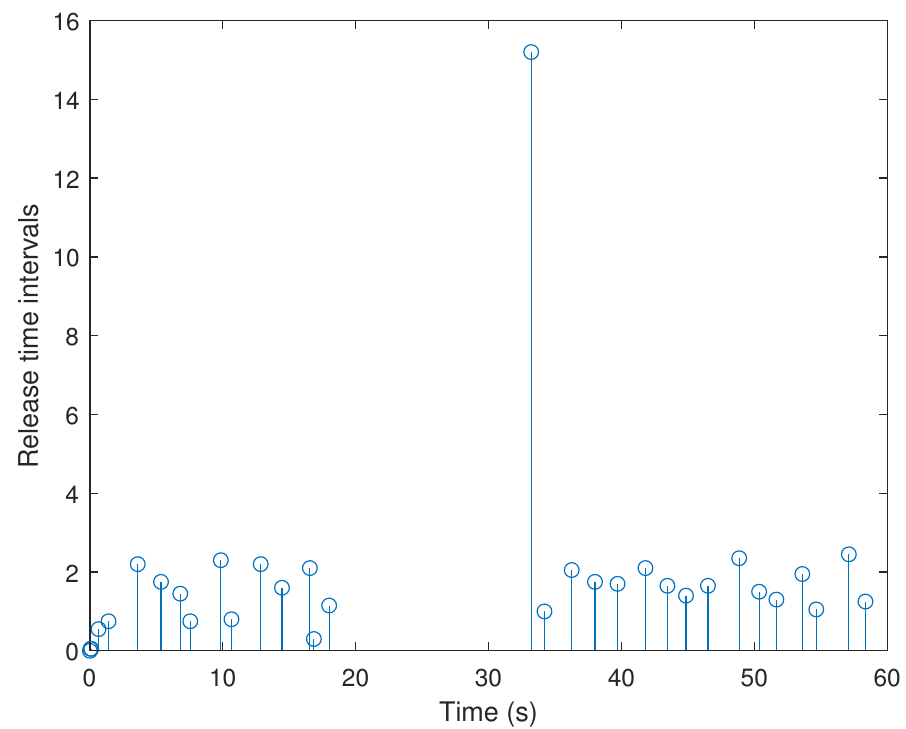
Figure 10. Release instants and release intervals with the adaptive ETS. As shown in Table 4, the number of sampling data is 1200 within 60 s. Under the adaptive ETS (6) proposed in this paper, the number of released packets is 31, and the DRR is 2.58%. Compared to the DRR = 3.58% of the conventional ETS, the proposed